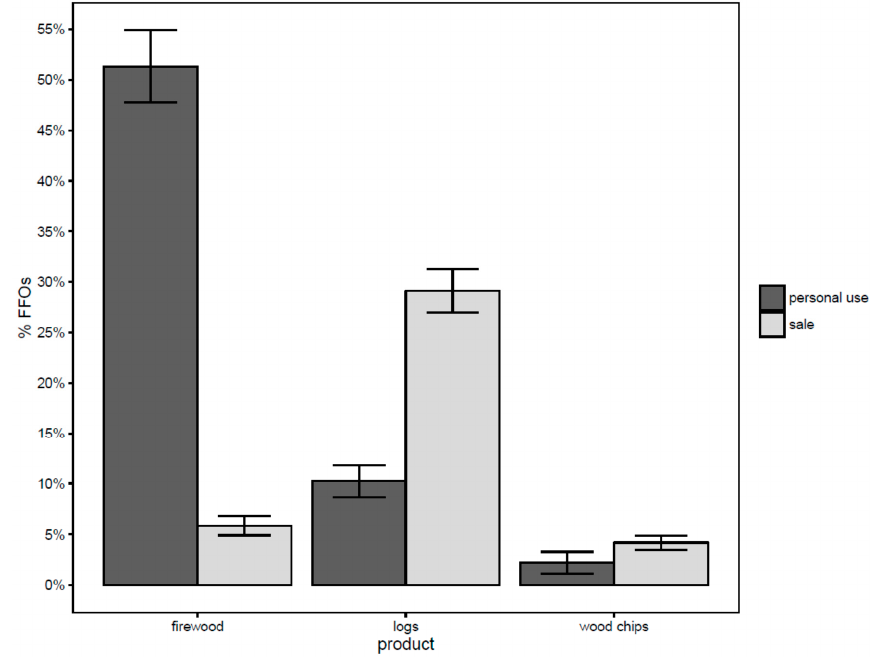
Figure 2. Estimated proportion of family forest ownerships (4+ ha) producing wood products, by product and beneficiary, United States, 2011–2013. Error bars represent two standard errors. Fewer landowners harvest NTFPs (Figure 3) than traditional wood products. The largest proportion have collected products for personal use, especially edibles (25.4%, SE = 1.2%), landscaping materials (12.5%, SE = 0.9%), and decorative goods (12.1%, SE = 0.9%). Fewer than 1.2%